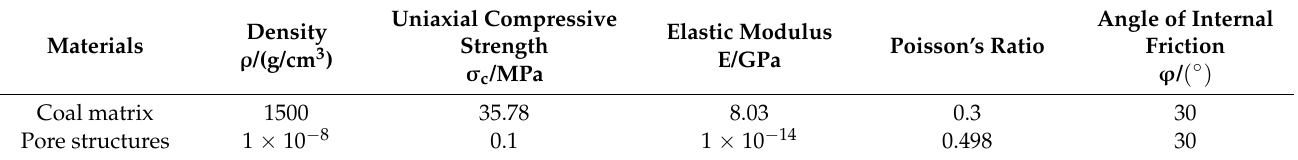
Table 2. Parameters used in RFPA numerical simulation model.